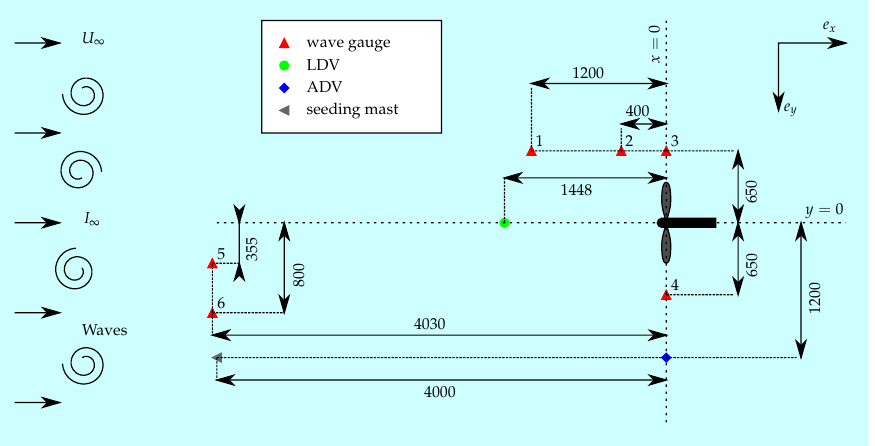
Figure 3. Schematic top-view of the test set-up used in the three tanks. The ADV is used at I FREMER , F LO W AVE and C NR -I NM . The LDV is only used at I FREMER . The seeding mast is required at C NR -I NM only. The wave gauges 1 to 3 are used at I FREMER and F LO W AVE and 3 to 6 at C NR -I NM . Dimensions are given in mm and the presented tank width represents the I FREMER